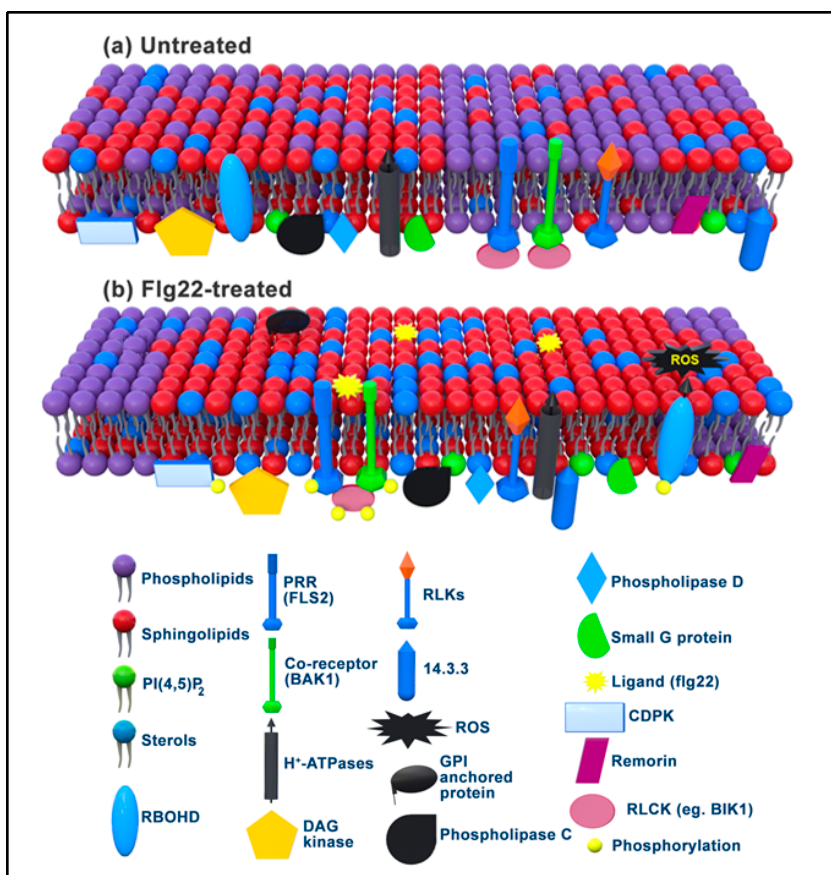
Figure 2. A model for localisation of PRRs in membrane rafts upon flg22 MAMP elicitation in A. thaliana . ( a ) Non-stimulated cells contain FLS2, BAK1 and other RLKs in non-raft domains (dominated by phospholipids), with inactive RbohD, PIP2-PLC, DGK typical raft protein markers (like remorin). ( b ) In flg22 treated cells, FLS2 forms a complex with BAK1 in DIMs (dominated by sphingolipids and sterols), that follows with recruitment of the RLCK BIK1 to the FLS2-BAK1 complex. Transphosphorylation events lead to RbohD activation and downstream defence signalling. Other components of DIM include CDPK, Phospholipase D (PLD), Phospholipase C (PLC), small G protein (Rac) and channel proteins (adapted from [28,65,66,73]).